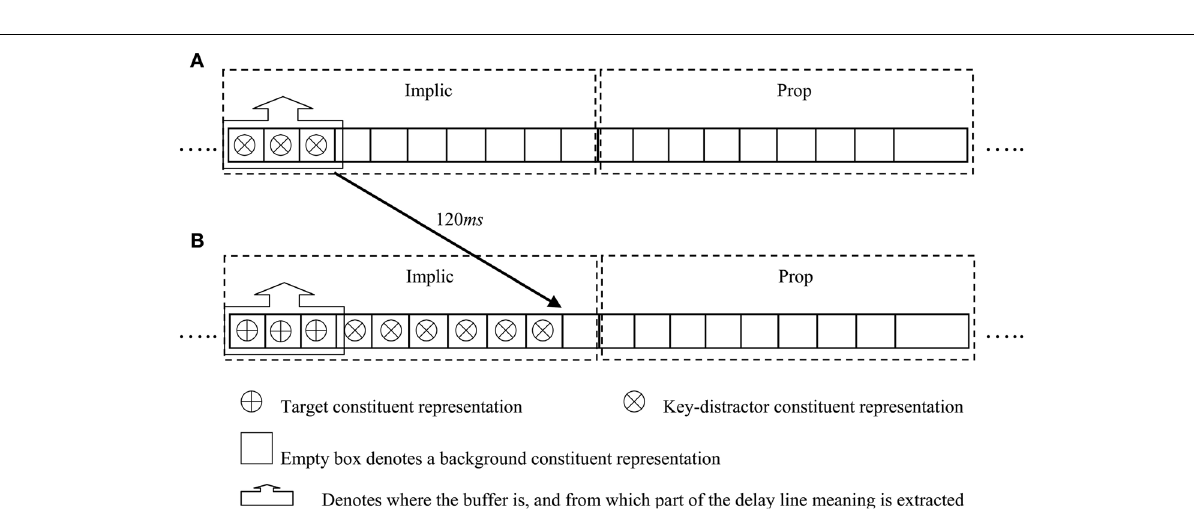
FIGUREA2 | Snapshots of the delay-line in the lag-1 case when (A) Implic decides to move the buffer to Prop after it has processed the first three constituent representations of the key-distractor; (B) the buffer actually moves just after Implic has processed the first three constituent representations of the